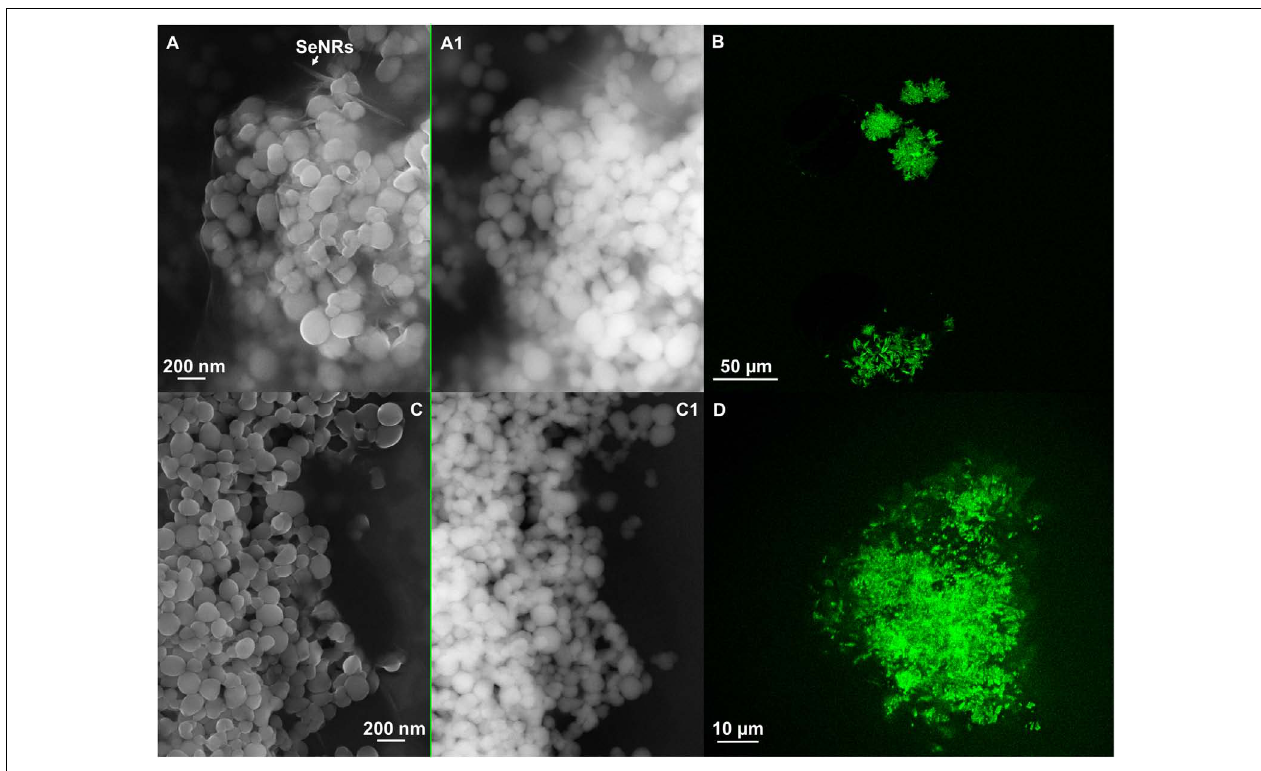
FIGURE 7 | Scanning electron microscopy of SeNS MPV1 − G_e [ A (In Lens detector), A1 (detector for back scattered electron)] and SeNPs MPV1 − P_e [ C (In Lens detector), C1 (detector for back scattered electron)]. Confocal laser scanning microscopy (CLSM) of SeNS MPV1 − G_e (B) and SeNPs MPV1 − P_e (D) labeled with the lipophilic tracer DiOC 18 (3).